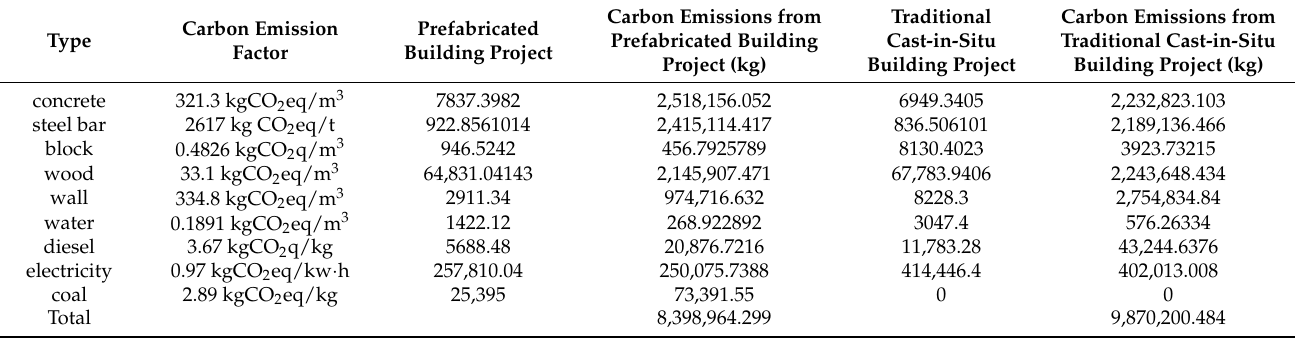
Table 1. Differences in carbon emissions during the field installation stage of the project.